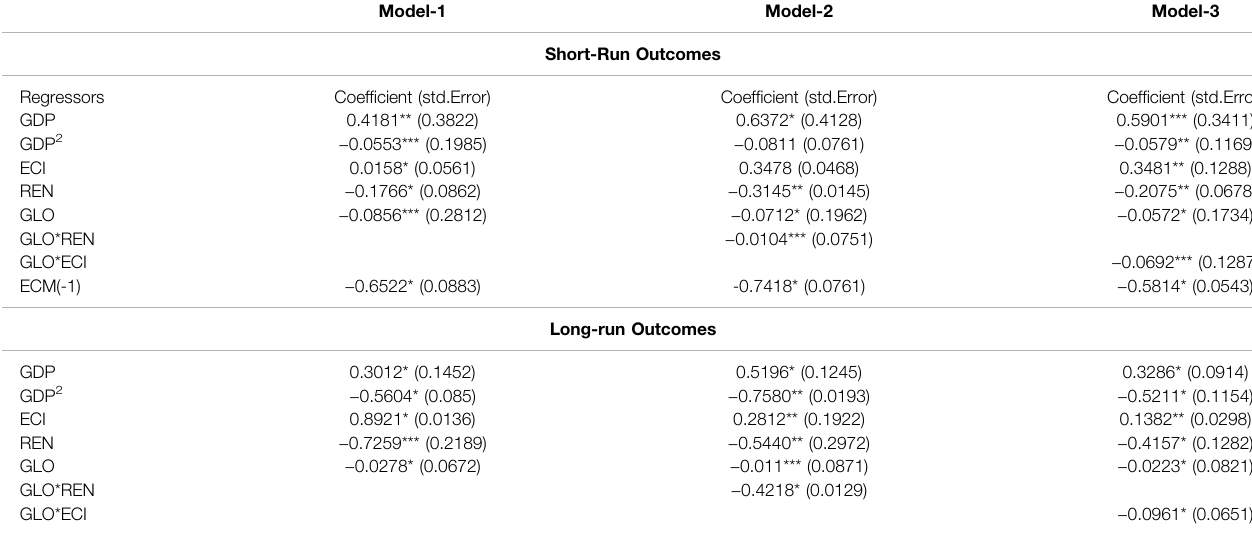
TABLE 7 | CS-ARDL short and long-run outcomes.